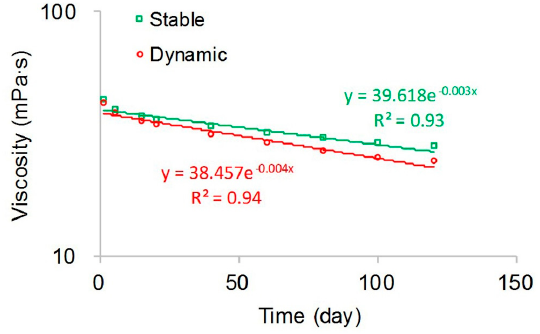
Figure 6. Polymer static and dynamic degradation curves.